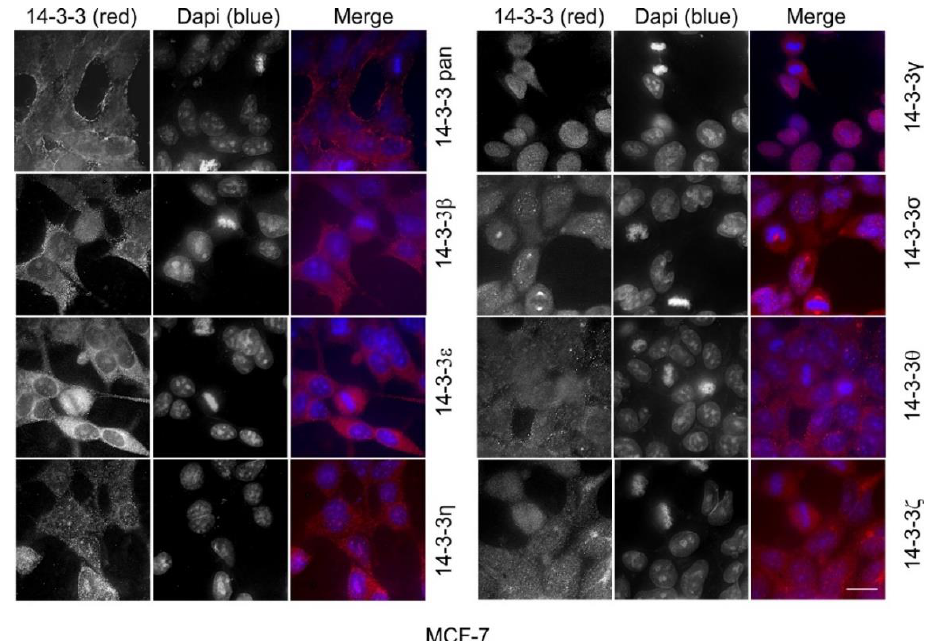
Figure 13. Subcellular localization of the total 14-3-3 protein and the seven 14-3-3 isoforms in MCF-7 cells by immunofluorescence. The total 14-3-3 proteins were determined by a pan14-3-3 antibody. Each 14-3-3 isoform was determined by antibodies to each specific isoform. Immunoblotting, immunofluorescence, and subcellular fractionation were performed as described in Materials and Methods. 14-3-3 proteins were revealed by TRITC (red) and the chromatin was stained by DAPI (blue). Scale bar = 10 µm.